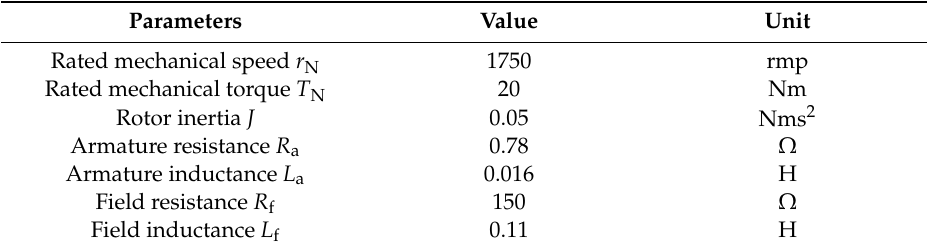
Figure 10. Block diagram of the simplified dc motor-based constant power load. Table 2. The dc motor